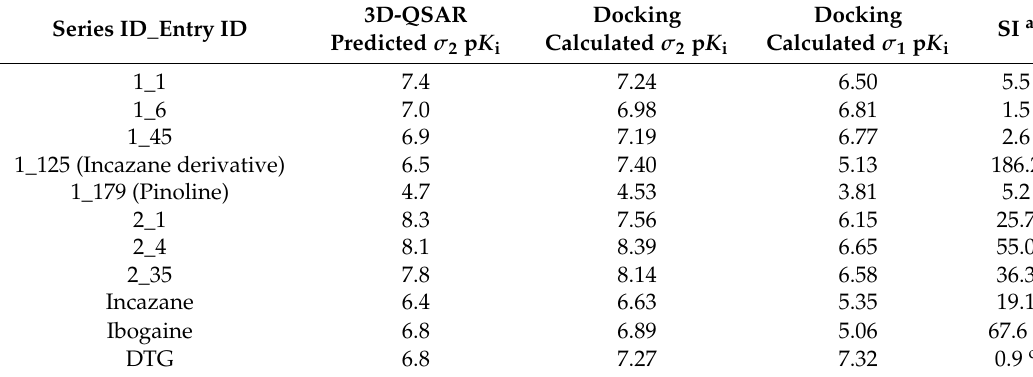
Table 3. Docking calculated σ 2 p K i values compared to the 3D-QSAR predicted ones and docking calculated σ 1 p K i values with σ 1 / σ 2 selectivity index for selected compounds.